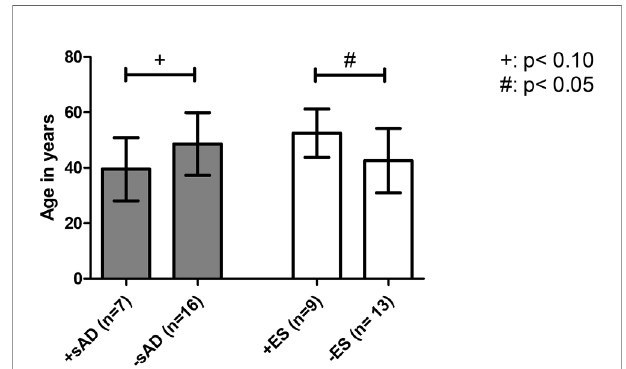
FIGURE 1 | Age at aHSCT as a risk factor for developing an iAE. Comparison of the mean age at aHSCT as a risk factor between transplanted SSc patients with the onset of ES (+ES) and without the onset of ES ( − ES) and patients with the onset of sAD (+sAD) and without sAD ( − sAD). Older mean age at aHSCT was found to be associated with the development of ES. iAE, immunological adverse event; aHSCT, autologous hematopoietic stem